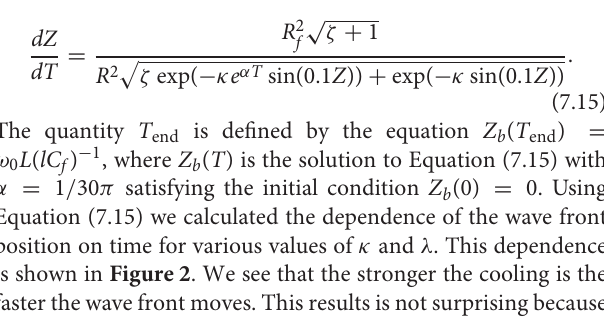
1.5. The upper, = 1 / 3, =